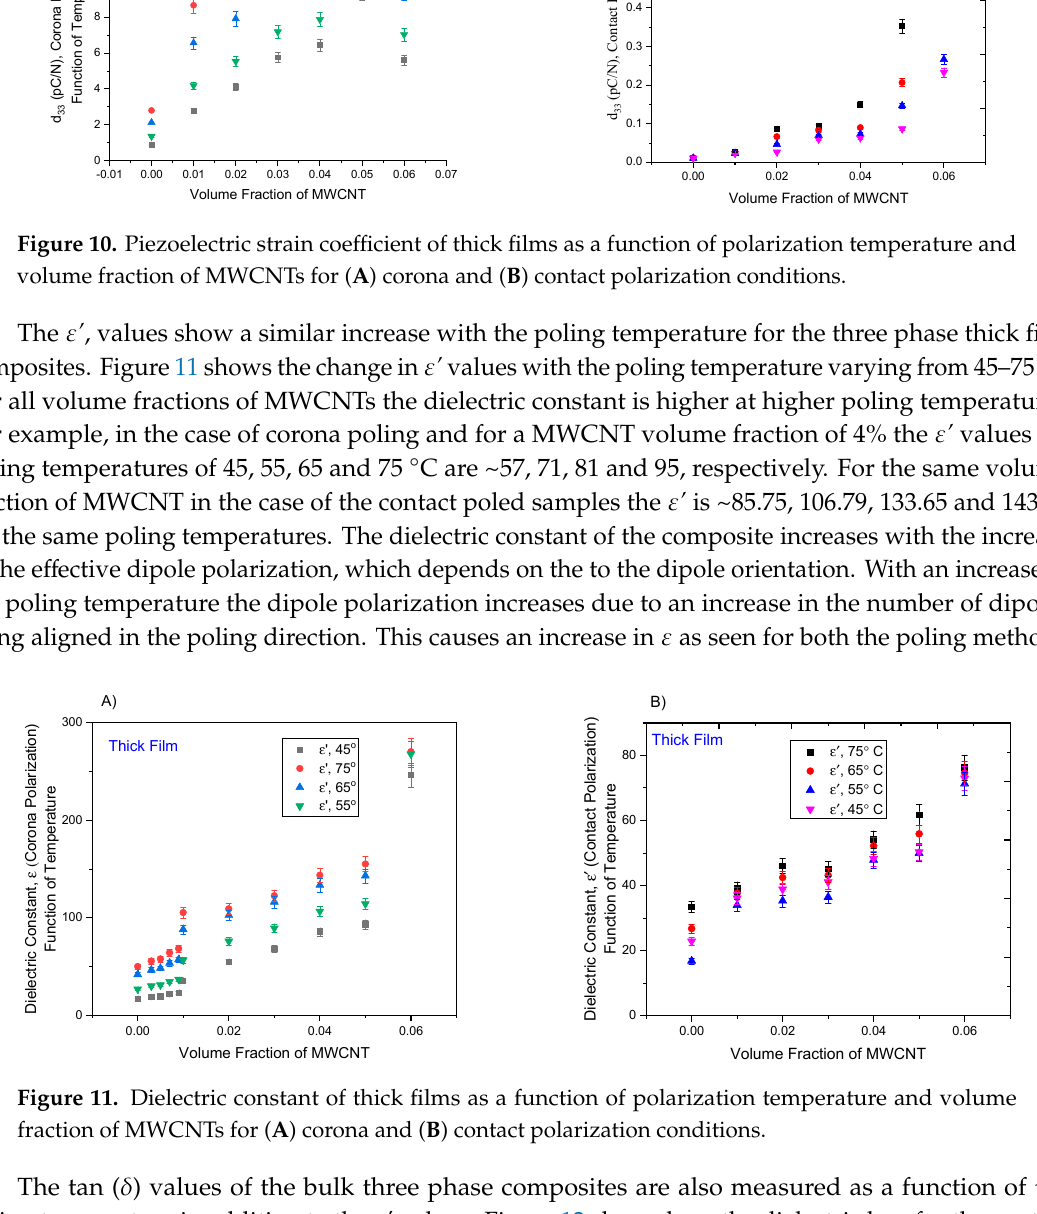
Figure 12. Dielectric loss, tan δ , of thick films as a function of polarization temperature and volume fraction of MWCNTs for ( A ) corona and ( B ) contact polarization conditions. 3.5. SEM Characterization of Films